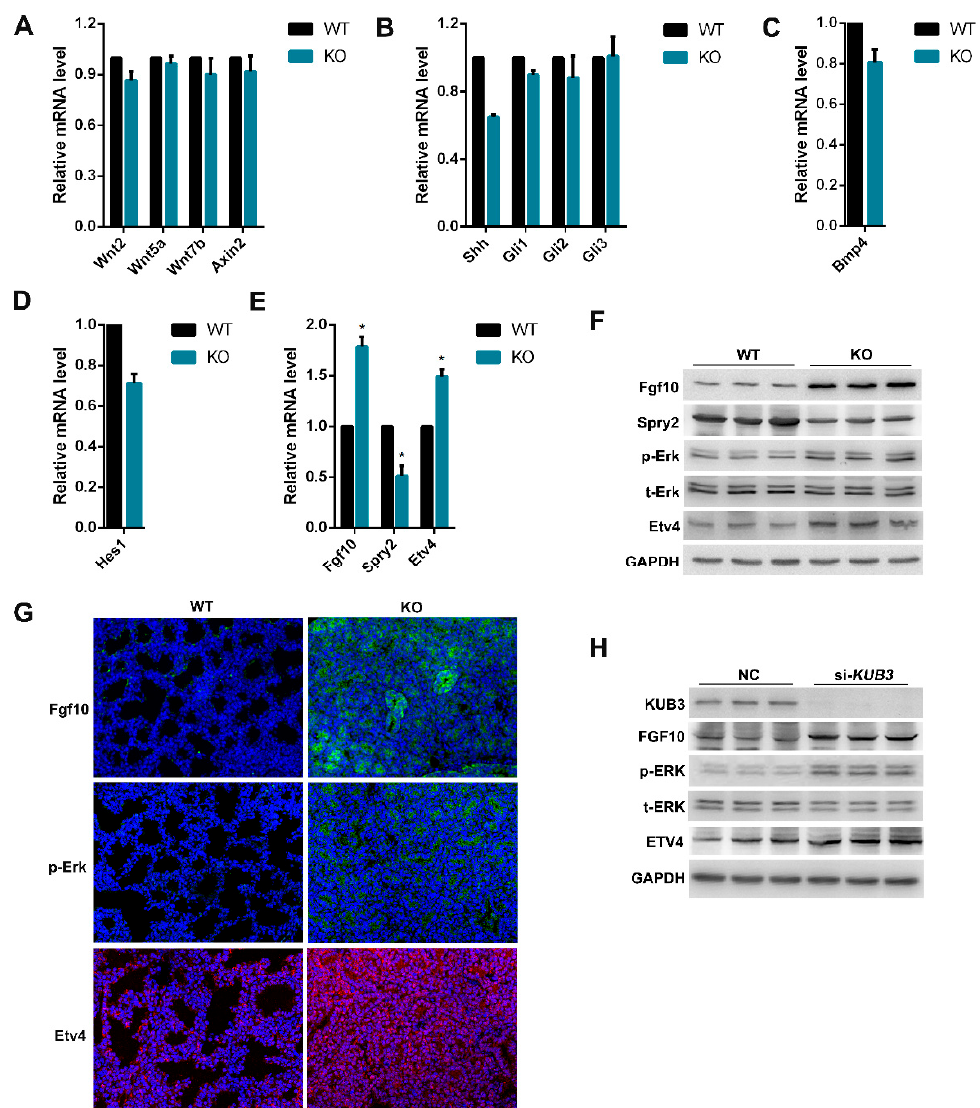
Figure 6. Kub3 deletion results in an abnormal FGF signaling pathway. ( A – E ) Quantitative RT-PCR analysis of the mRNA levels of marker genes for the Wnt, Shh, Bmp, Notch, and FGF signaling pathways, respectively. The data are derived from three independent experiments and are normalized to the GAPDH ( n = 3. * p < 0.05). ( F ) Protein levels of marker proteins for the FGF signaling pathway in E18.5 lungs. Protein lysates were subjected to Western blot performed with the indicated antibodies. GAPDH was used as a loading control. ( G ) Immunostaining of Fgf10, p-Erk, and Etv4 in E18.5 lung sections. ( H ) Western blot analysis of marker proteins for the FGF signaling pathway in HEK293 cells. GAPDH was used as a loading control.